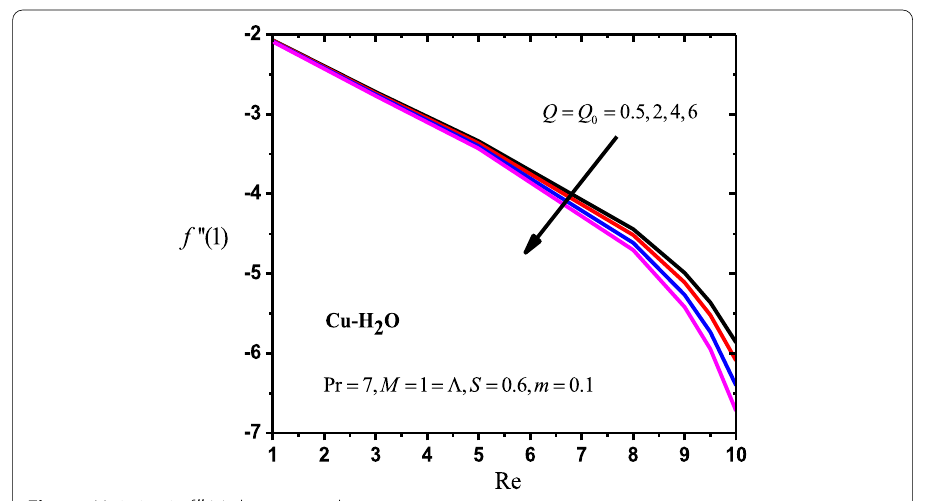
Fig. 14 Variation in f ′′ ( 1 ) due to Re and Q